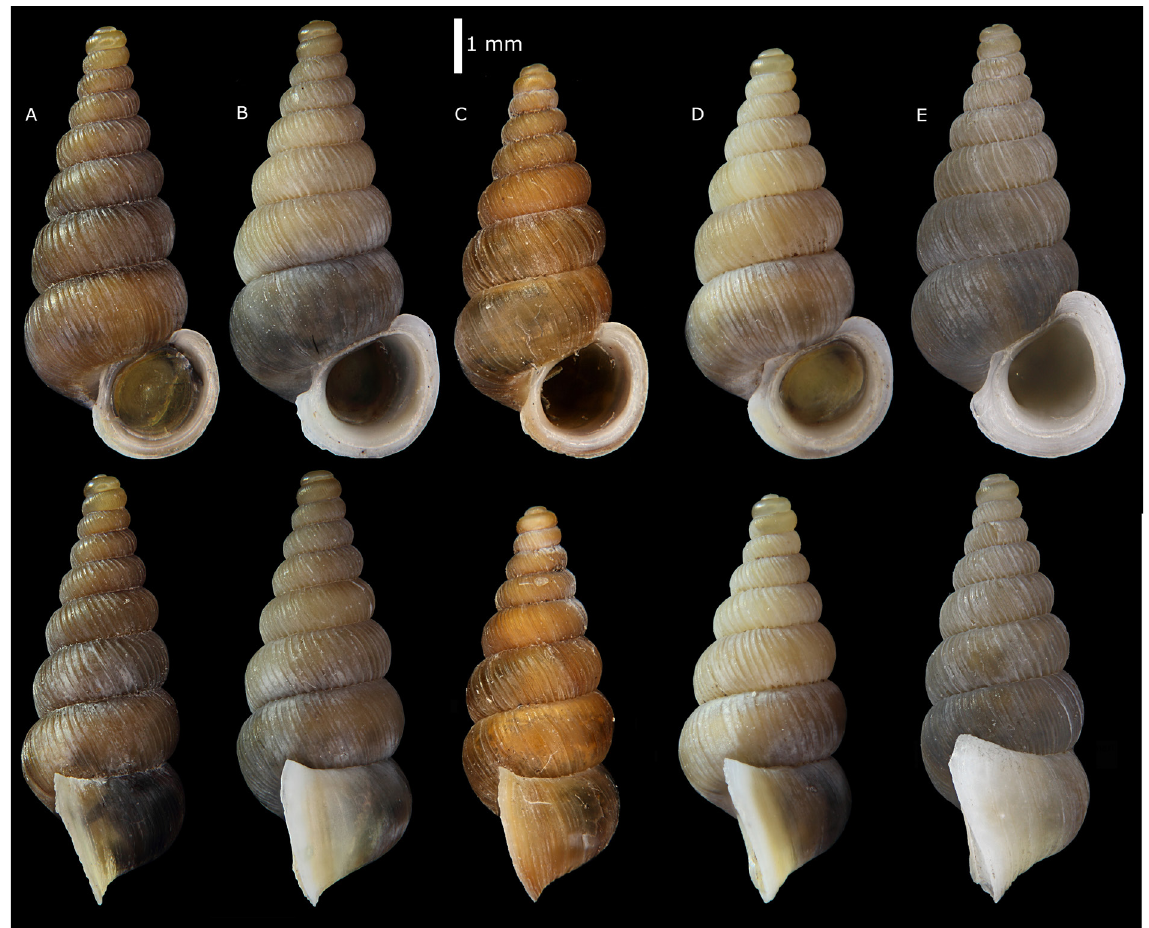
Fig. 31. Shell variability in Cochlostoma ( Clessiniella ) waldemari (A.J. Wagner, 1897). A . Polog-E of Čepovan, Slovenia (WdM6842). B . Vrsic Pass, Slovenia (EZ0896). C . Benete, Slovenia (WdM6805). D . Mt Klek, Croatia (EZ0904). E . Bresovica pri Predgradu, Slovenia